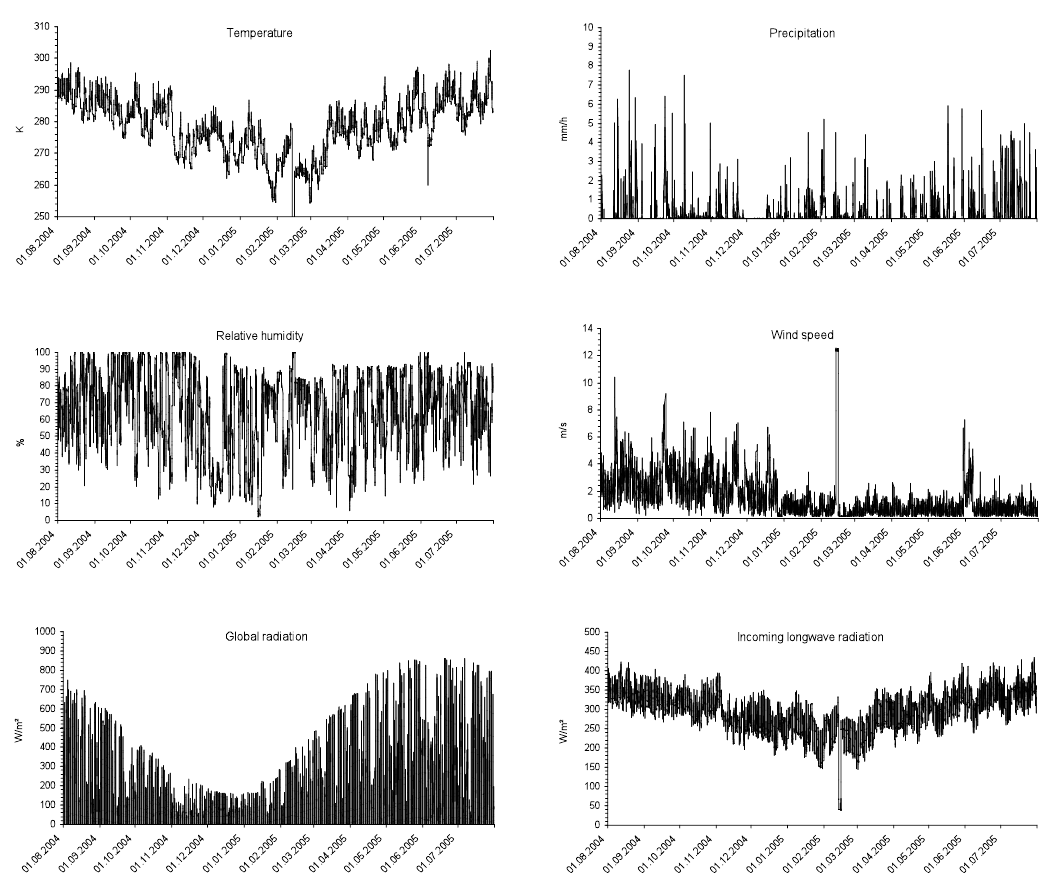
Fig. 3. Hourly meteorological observations from Kuehroint AWS (1407ma.s.l.) used for the simulations with ESCIMO.spread . The diagrams show the uncorrected meteorological recordings.